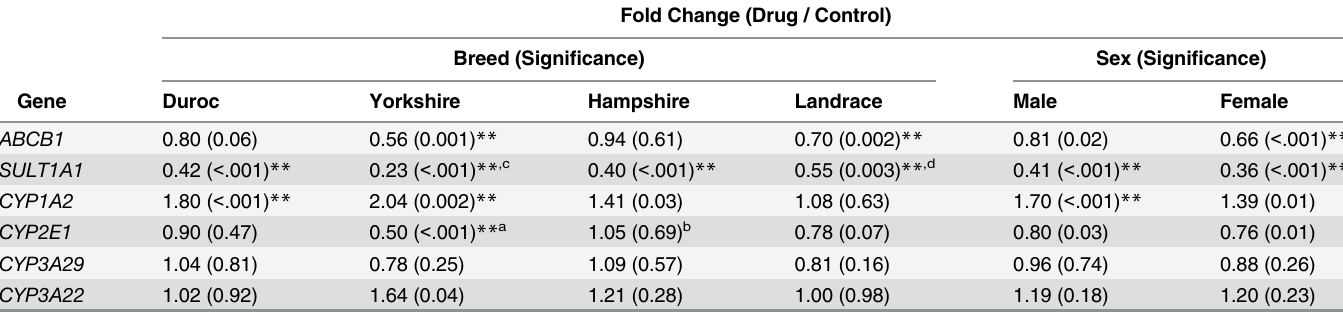
Table 3. The fold-change (Significance) 1,2 between animals given a drug and the control within each breed and sex for flunixin meglumine across target genes.